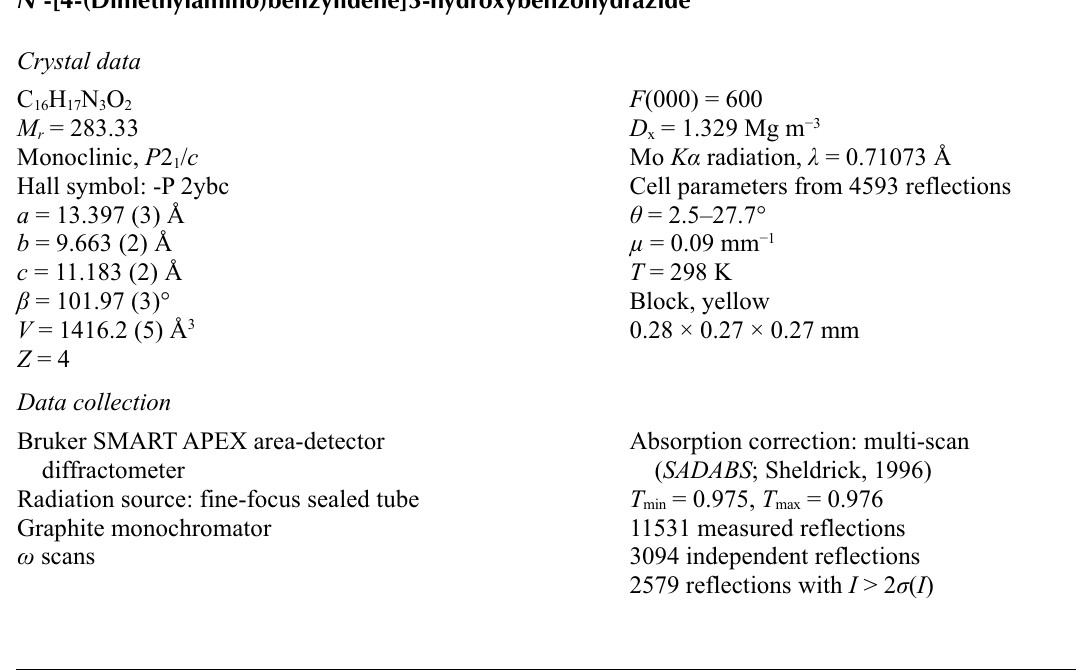
Crystal packing of the title compound view along the a axis [hydrogen bonds are drawn as dotted